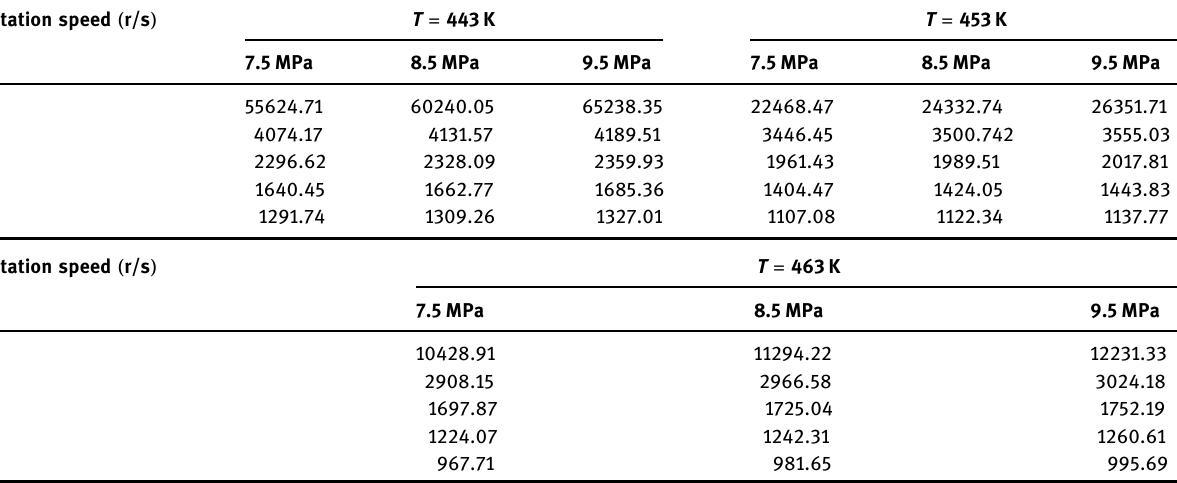
Table 2: The dynamic viscosity ( Pa s ) of PS under shear condition Rotation speed ( r/s